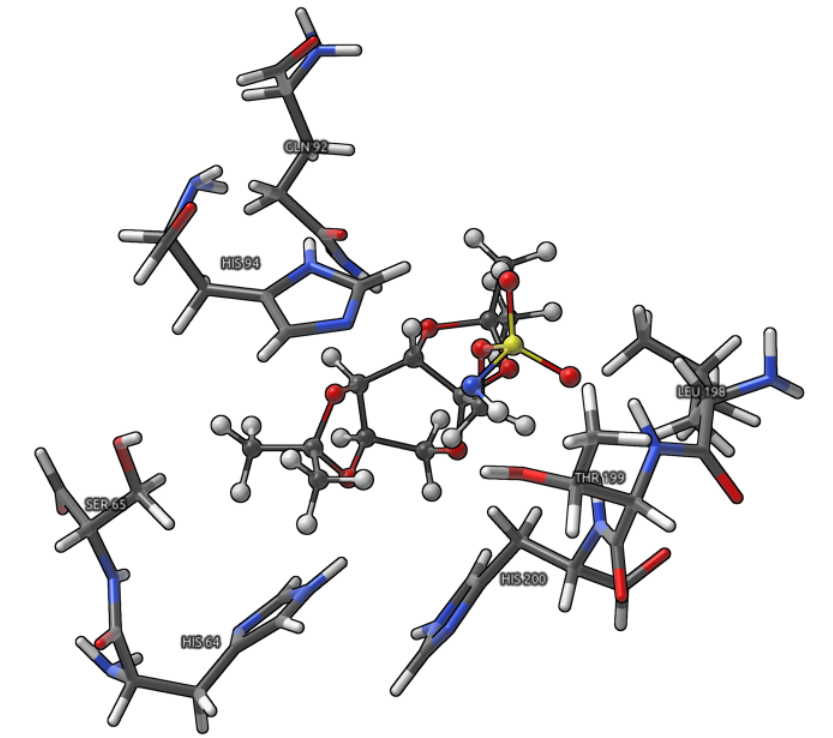
Figure 4. Graphical representation of the model used for SAPT energy decomposition. Topiramate is presented as CPK model, whereas amino acids of the binding site as licorices. Color coding: white—hydrogen, grey—carbon, red—oxygen, blue—nitrogen, and